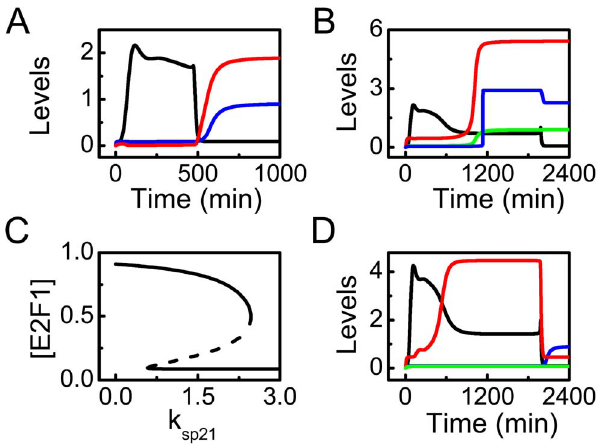
Figure 4. Role of PTEN in the two-phase dynamics of [p53 p ]. (A) Time courses of [p53 p ] at L D0 ~ 5 (black), 10 (red), or 20 (blue). (B) Maximum of [p53 p ] throughout the cellular response vs. L D0 . (C) Bifurcation diagram of [p53 p ] vs. the p53-inducible production rate of PTEN, k sPTEN , at fixed L D ~ 20 . (D) Time courses of [p53 p ] with k sPTEN ~ 0 (black) or 0.05 (red).